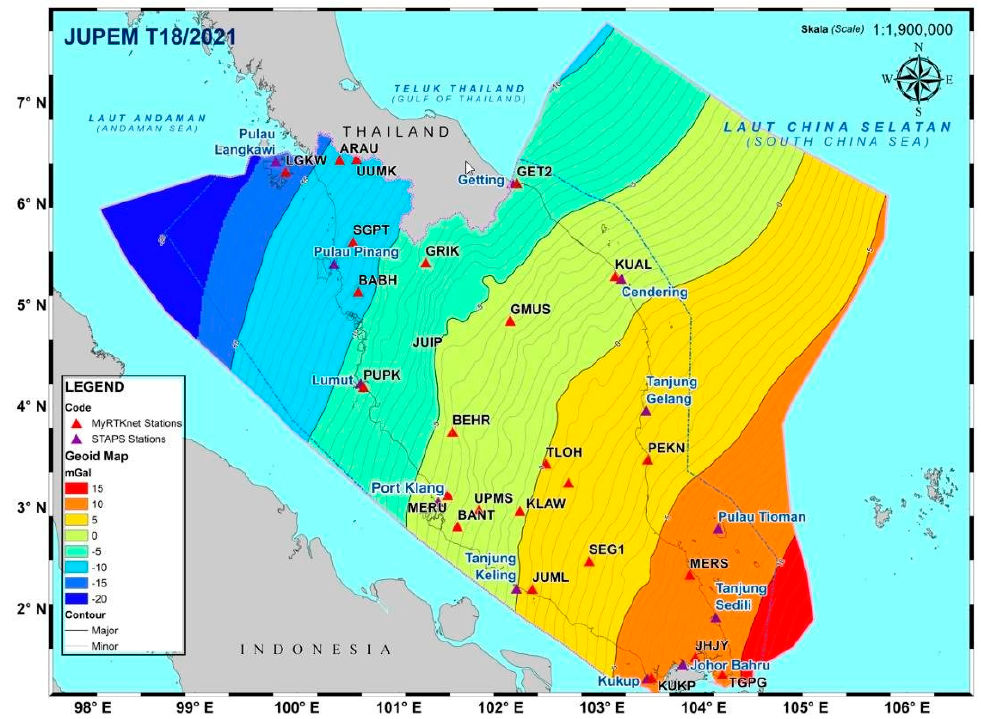
Figure 5. Location of tide gauge stations (blue triangles) and selected MyRTKnet stations (red triangles) are shown on the gravimetric geoid of Peninsular Malaysia, illustrating the integrated approach adopted in the present height reference system analysis.